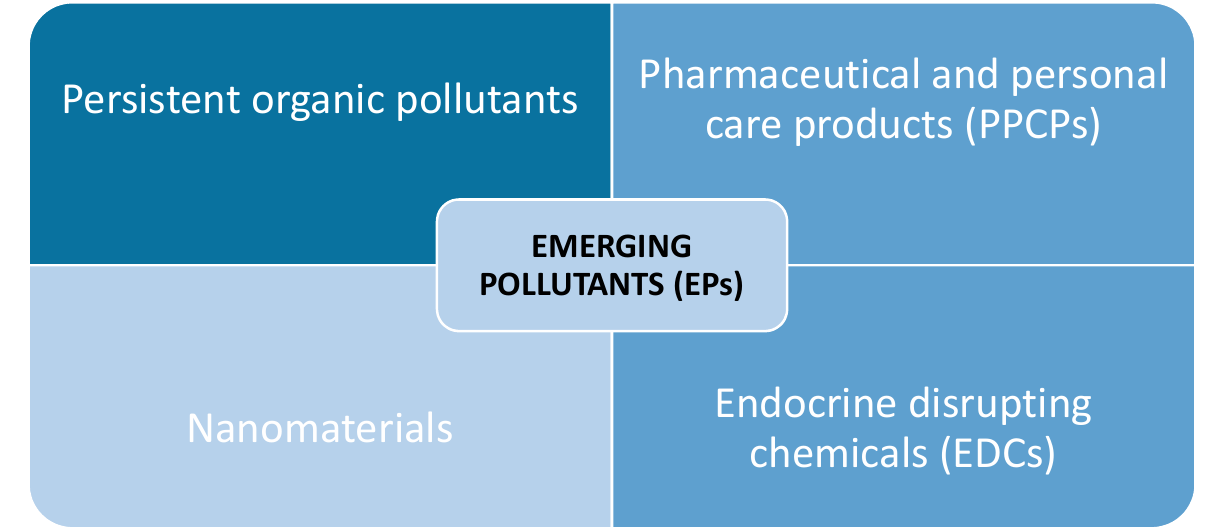
Figure 1. Influence of emerging pollutants (EPs) on environments.